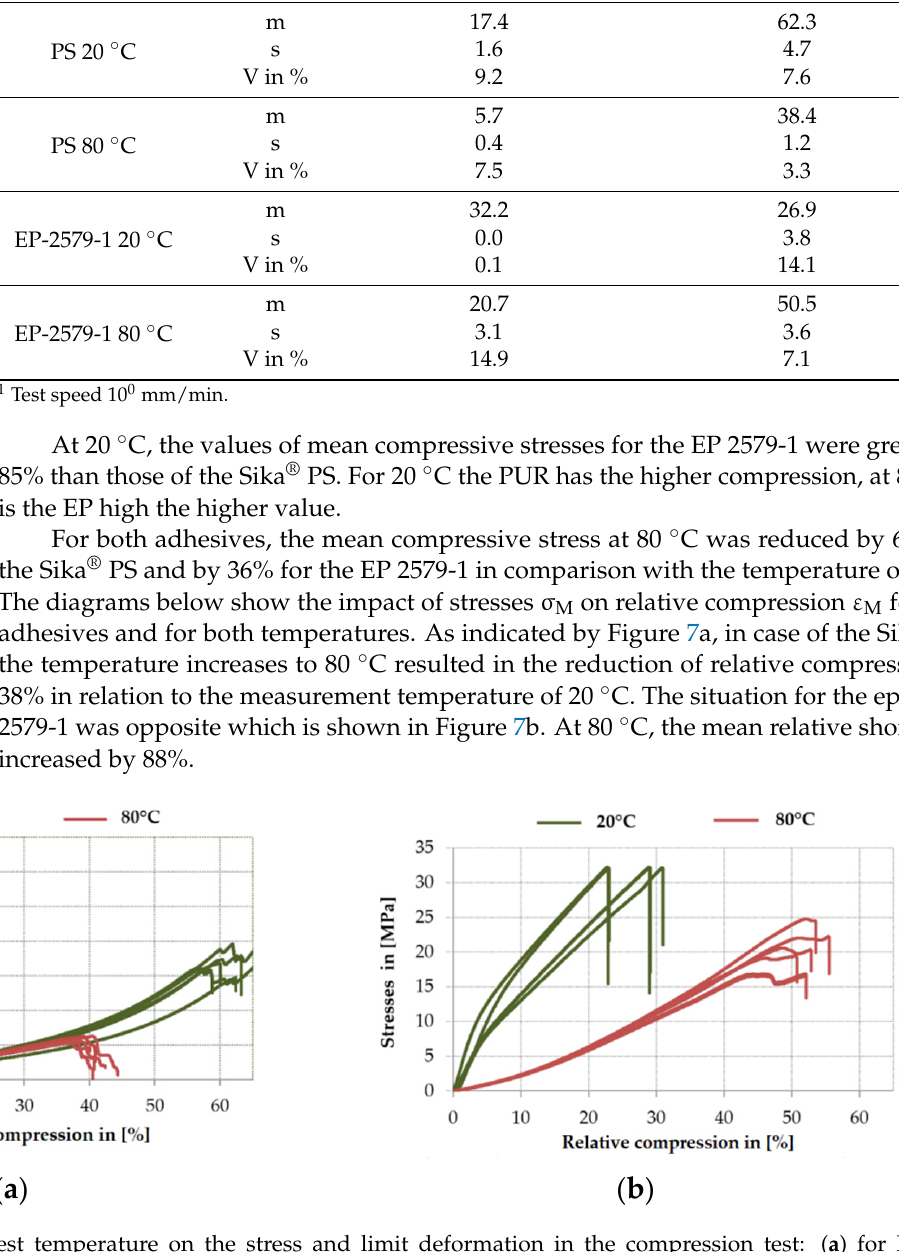
Table 3. Results for uniaxial compression test at 20 °C and 80 °C.